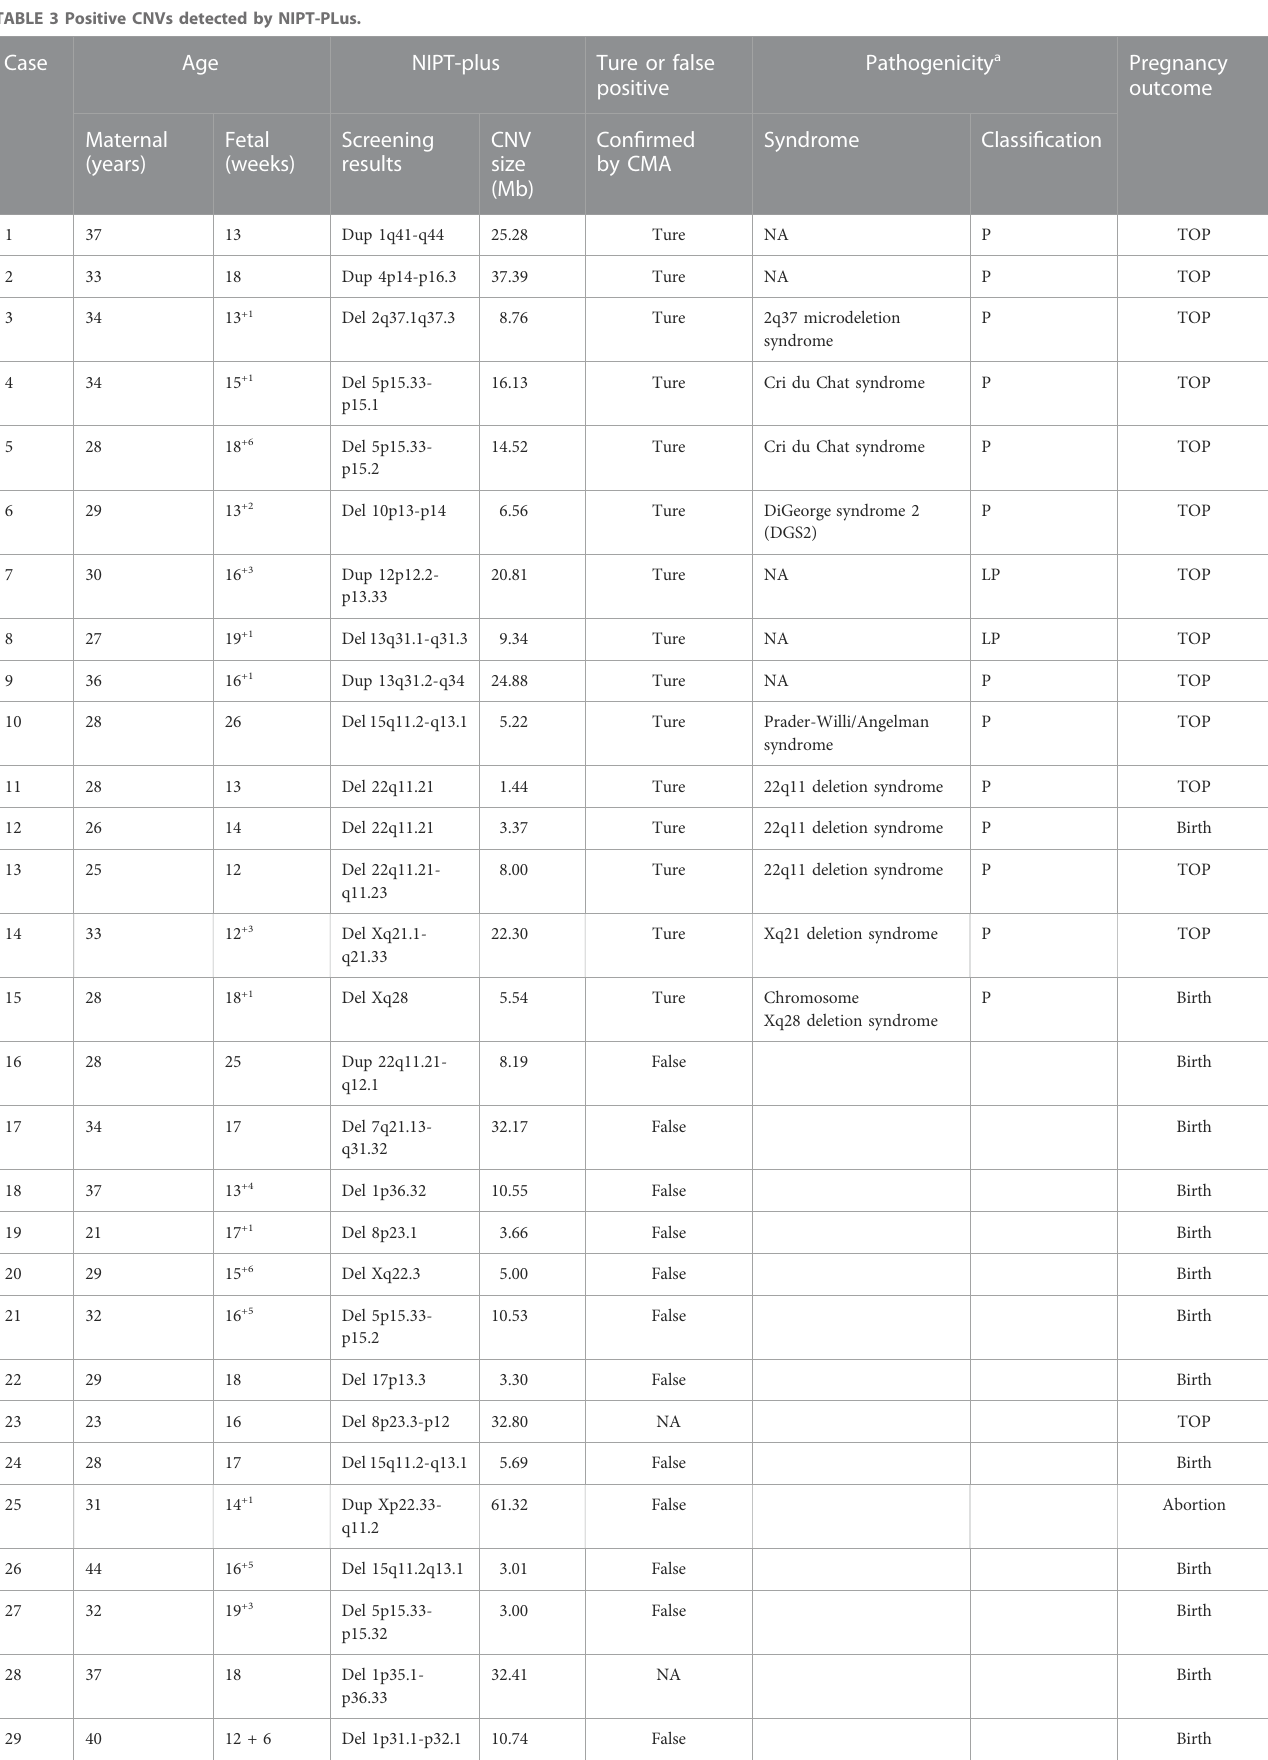
TABLE 3 Positive CNVs detected by